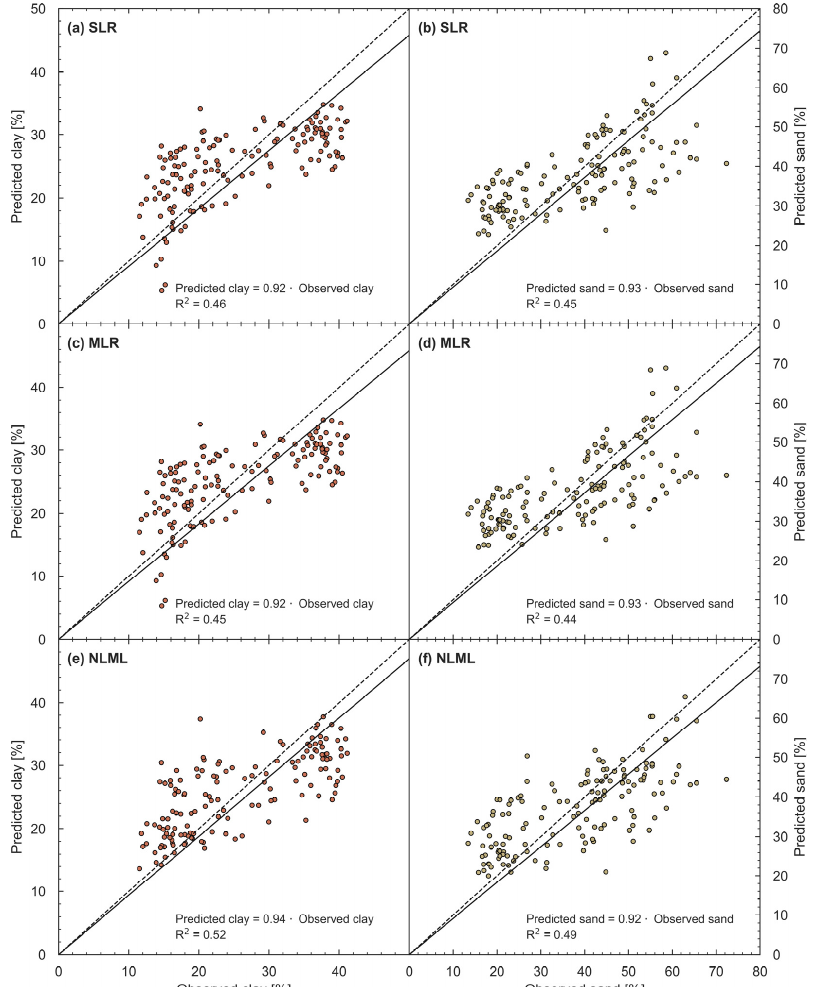
textural fractions predicted with the NLML algorithm. The performances of the three approaches (SLR, MLR and NLML) are compared by